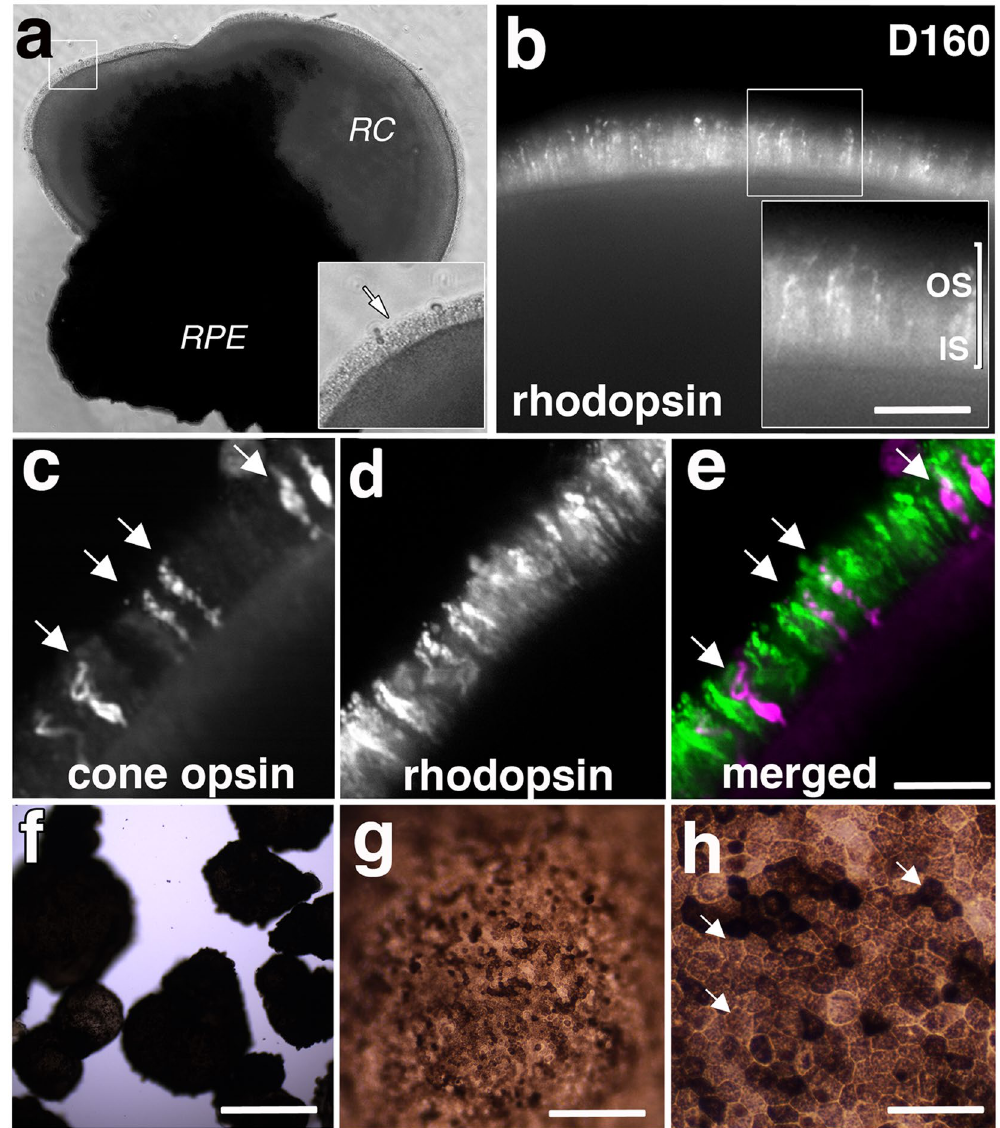
Figure 4. Photoreceptor outer segments express visual pigments in 160 day-old retina cups from IMR90.4 iPSCs. ( a ) A RC with a dense patch of RPE and POS-like structures (arrow). Low ( b ) and high (inset) magnification images of RC whole mounts with broad expression of rhodopsin in cells lining the edge of the RC. Cones ( c ; arrows) and rods ( d ) with discrete non-overlapping expression ( e ) patterns are confirmed by whole mount IHC using antibodies against rhodopsin and R/G cone opsin respectively. ( f – h ) Clusters of pigmented RPE grow as spheroid clumps within the culture dish. At high magnification ( h ) these appear as thin sheets of cuboidal shaped cells (arrows). POS = photoreceptor outer segment; RC = retina cup, RPE = retinal pigment epithelium. Scale bars ( b ) = 35 μ m, ( e ) = 50 μ m, ( f ) = 500 μ m, ( g ) = 200 μ m, ( h ) = 50 μ